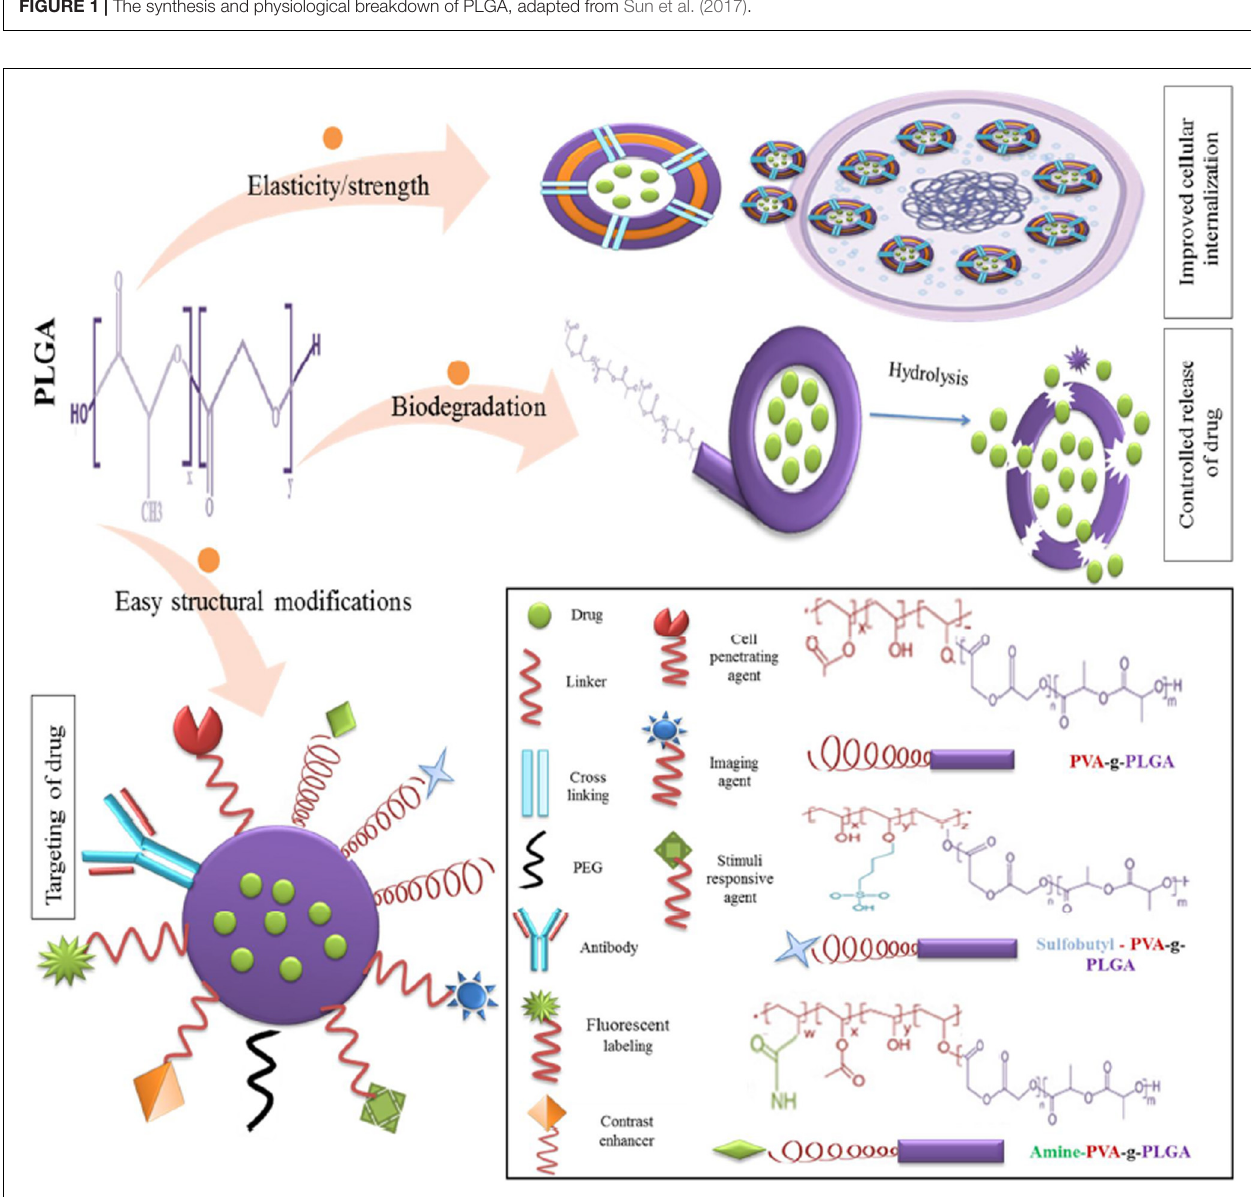
FIGURE 2 | Favorable characteristics of PLGA as a nano delivery system, reproduced from Mir et al. (2017).